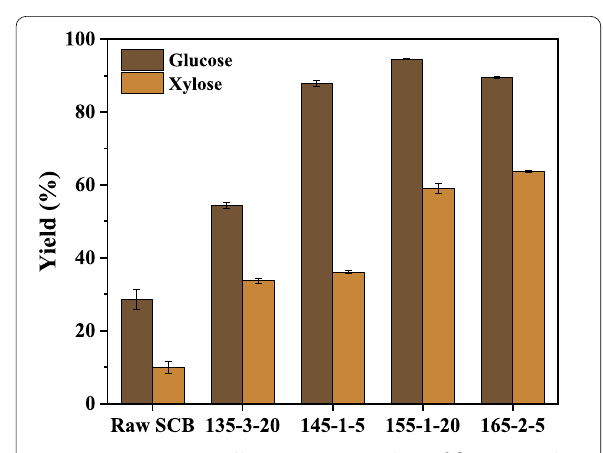
Fig. 4 X-ray diffraction (XRD) of SCB and solids pretreated by different processes